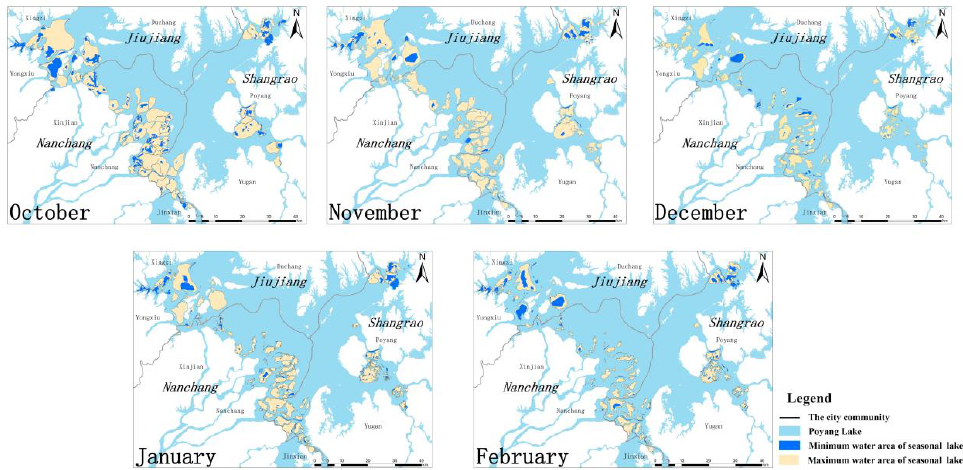
Figure 9. Variation in the maximum and minimum areas of seasonal lakes during the migration of migratory birds.